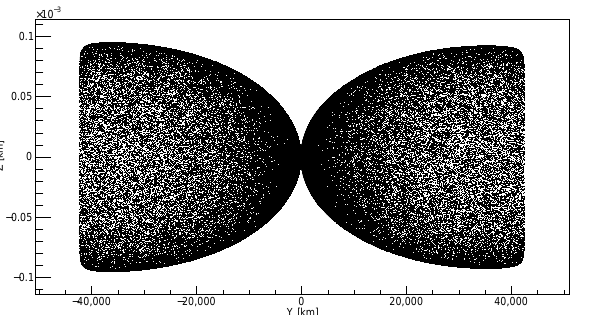
Figure 4. The spatial distribution of secondary photons at the top of the atmosphere produced in the exemplary simulation from Figure 3. Note the difference in the scales along the y and z